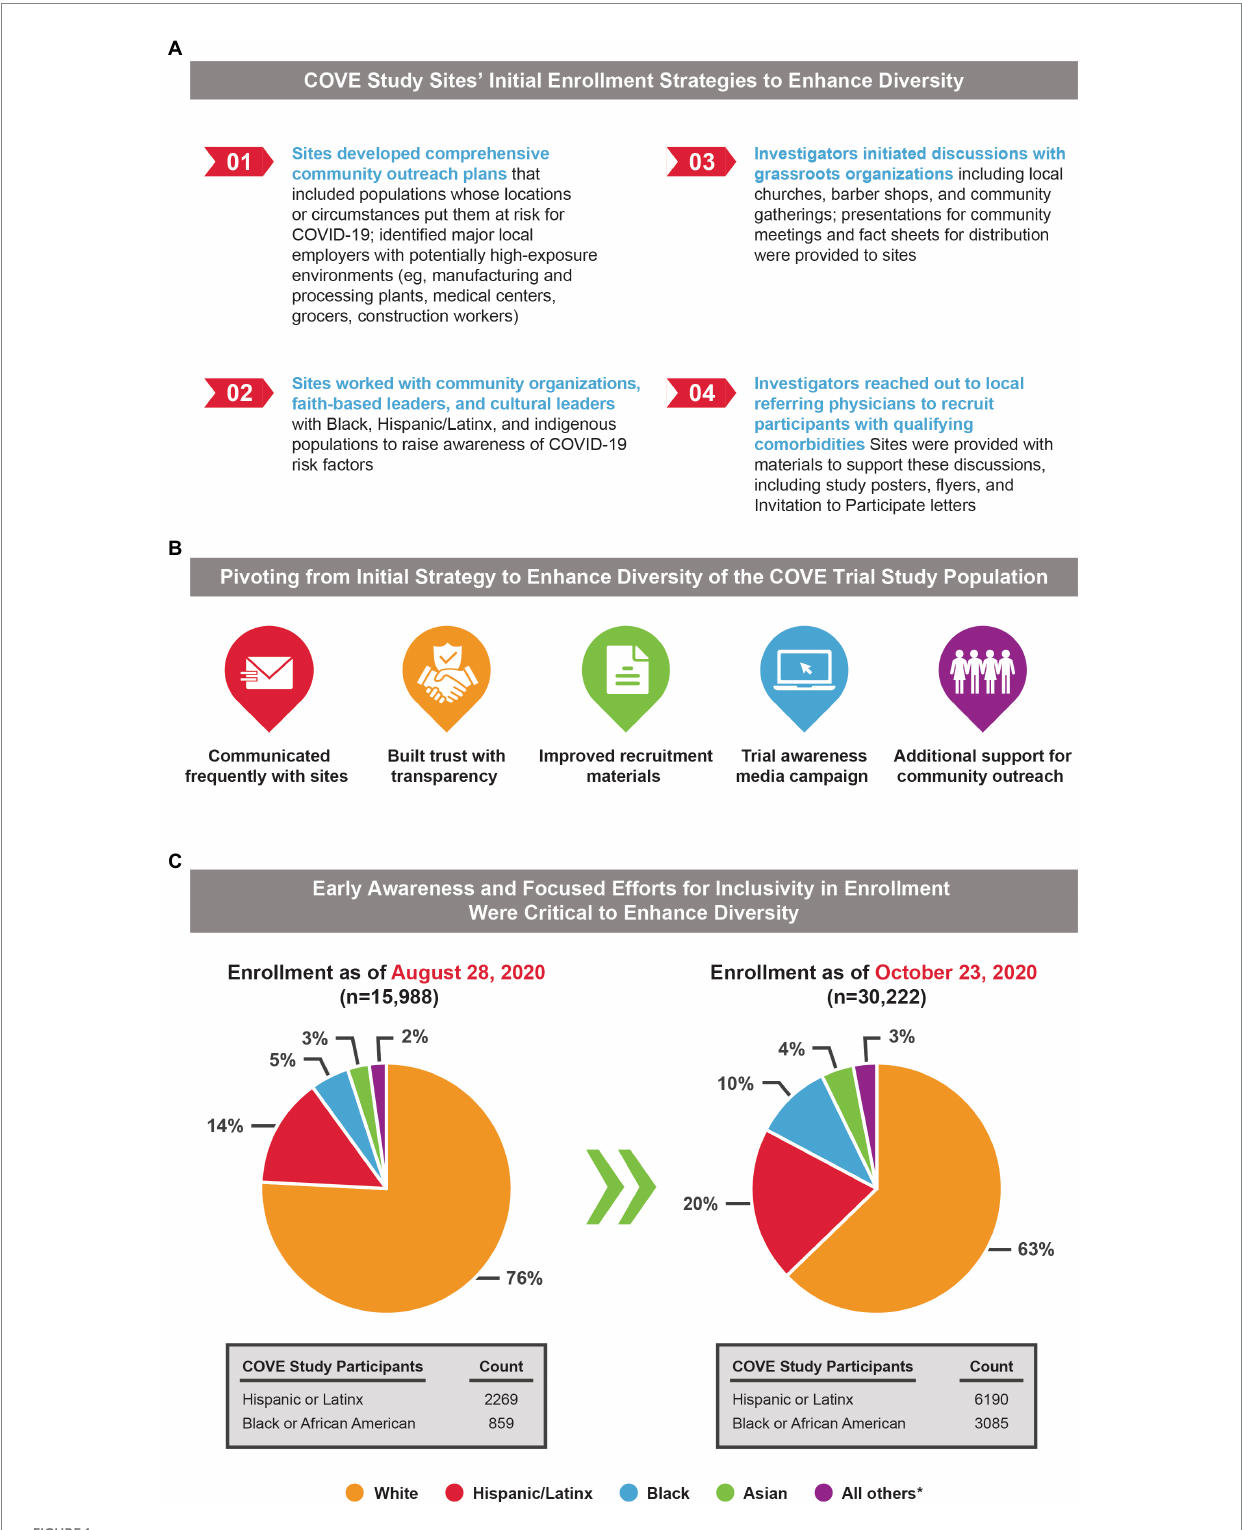
FIGURE 1 Initial enrollment strategy of the COVE study and the need for an evolving recruitment approach to achieve equitable representation in study populations. (A) The initial enrollment strategy for the COVE study was designed to target an inclusive and diverse study population reflective of the intended patient population. (B) Diverse representation initially lagged in the COVE study, and a multifaceted approach to address this unexpected challenge was implemented to help the study achieve equitable representation. (C) Pie charts present percentages of COVE participants within each demographic characteristic and highlight the under-representation of Black and Hispanic/Latinx Americans during the earlier timepoints of the trial, which was addressed by a pivoting from initial strategies. *Includes American Indian or Alaska Native, Native Hawaiian or other Pacific Islander, multiracial, not reported and unknown, or